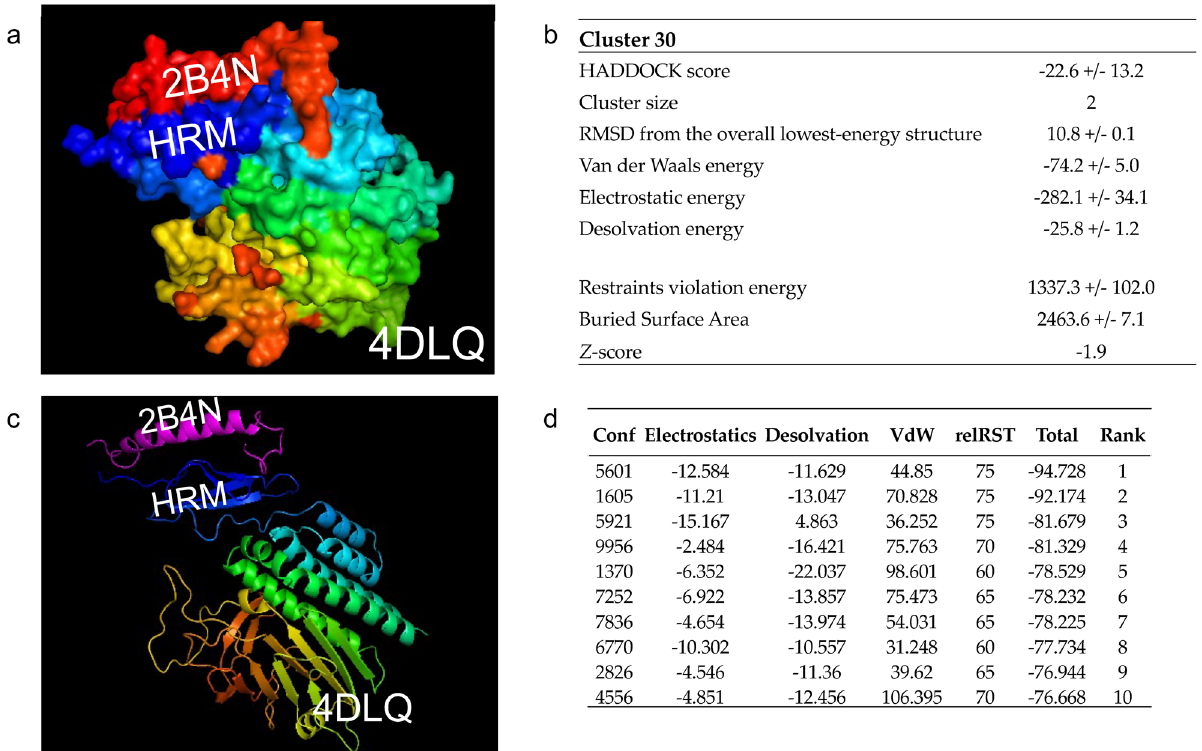
Figure 3. Binding residues corresponding to the 4DLQ and 2B4N proteins. ( a ) HADDOCK diagrammatic illustration of the best-docked complex of 4DLQ–2B4N (Rank 1). ( b ) Scoring functions for the best-docked complex, 4DLQ–2B4N. The Z -score indicates how many standard deviations from this cluster’s average are in terms of the score 103 . ( c ) 3D protein structure for the 4DLQ–2B4N complex was identified as the best-docked complex via pyDock (Rank 1). ( d ) Electrostatics, desolvation energy, limited Van der Waals (VdW) contribution scores and restraint-based scoring (relRST) were obtained by the pyDock scoring function. RMDS: Root Mean Square Deviation in